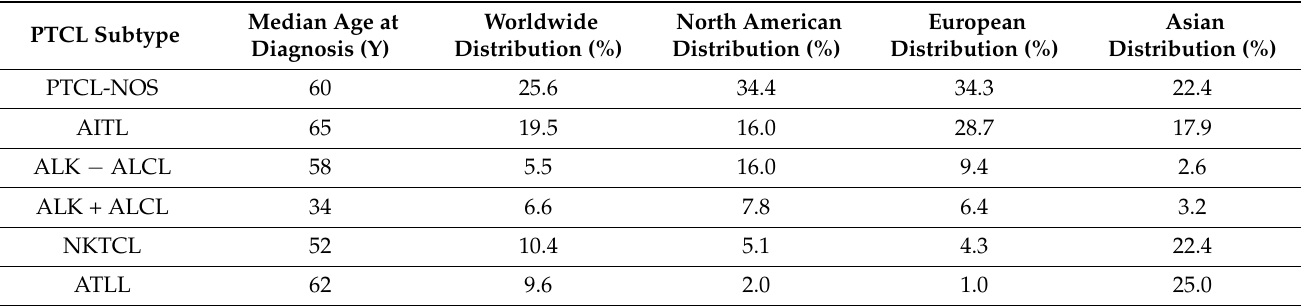
Table 1. PTCL Subtypes Distribution and Median Age at Diagnosis